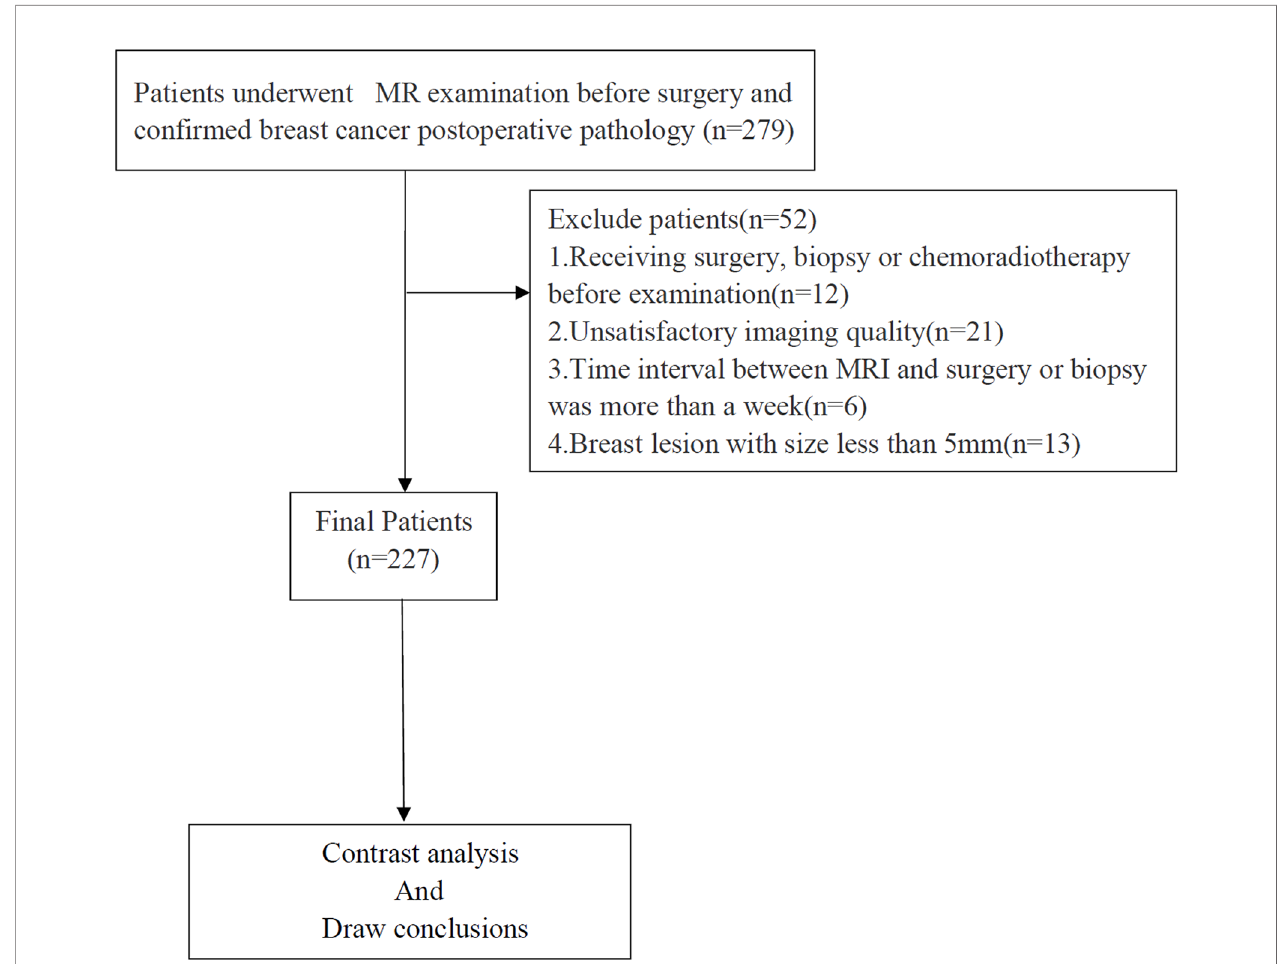
FIGURE 1 | Flowchart of the enrolled